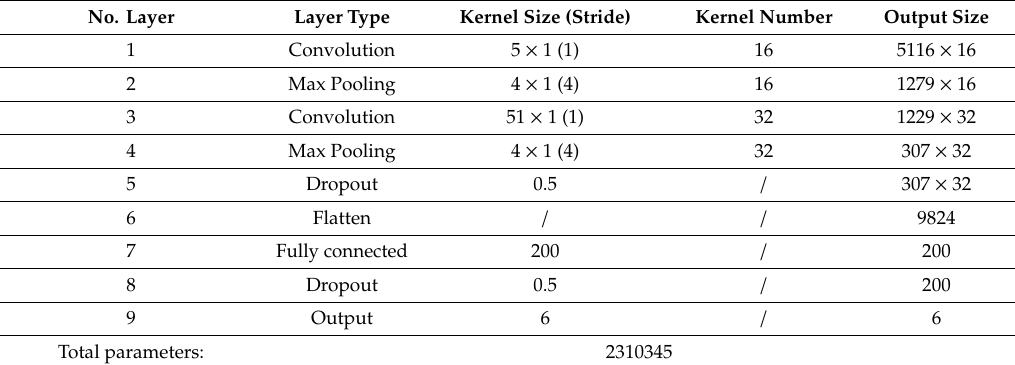
Table 1. Number of parameters used in the CNN.